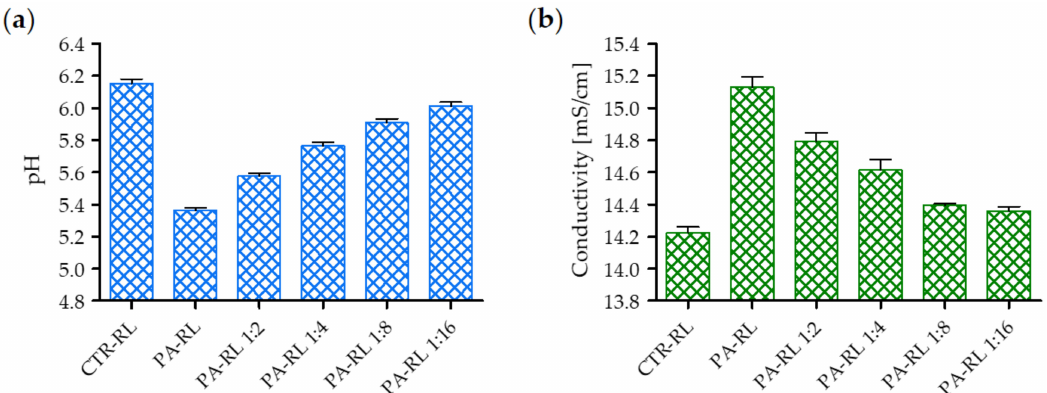
Figure 3. Chemical characterization of plasma-activated RL (PA-RL) and its dilutions after 10 min of plasma treatment at 18 kV. ( a ) pH and ( b ) conductivity as a function of serial dilutions. Data are presented as mean ± SEM ( n = 3).